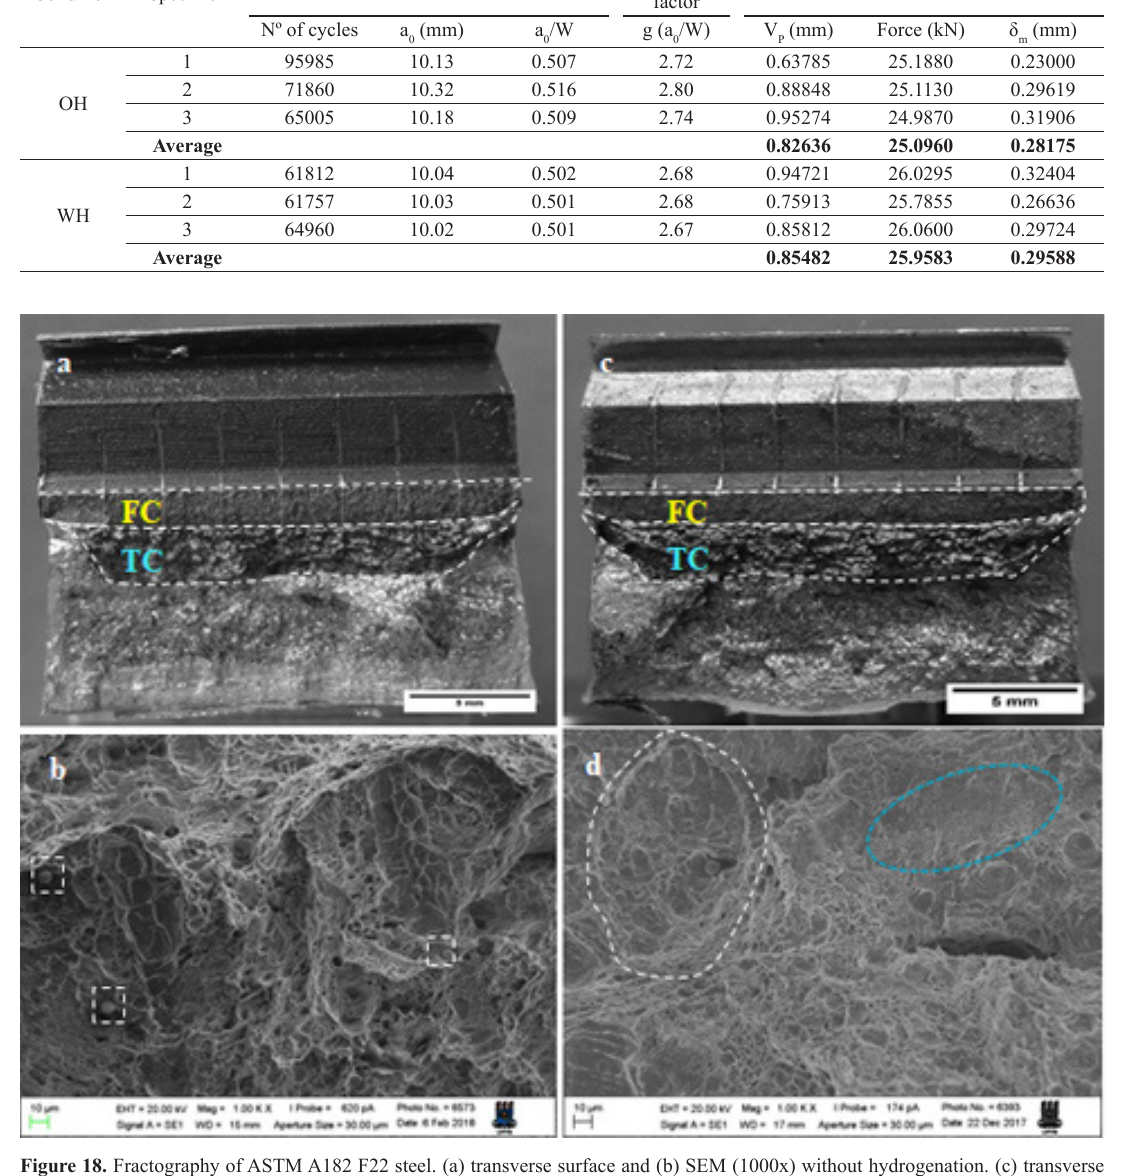
Figure 18. Fractography of ASTM A182 F22 steel. (a) transverse surface and (b) SEM (1000x) without hydrogenation. (c) transverse surface and (d) SEM (1000x) with